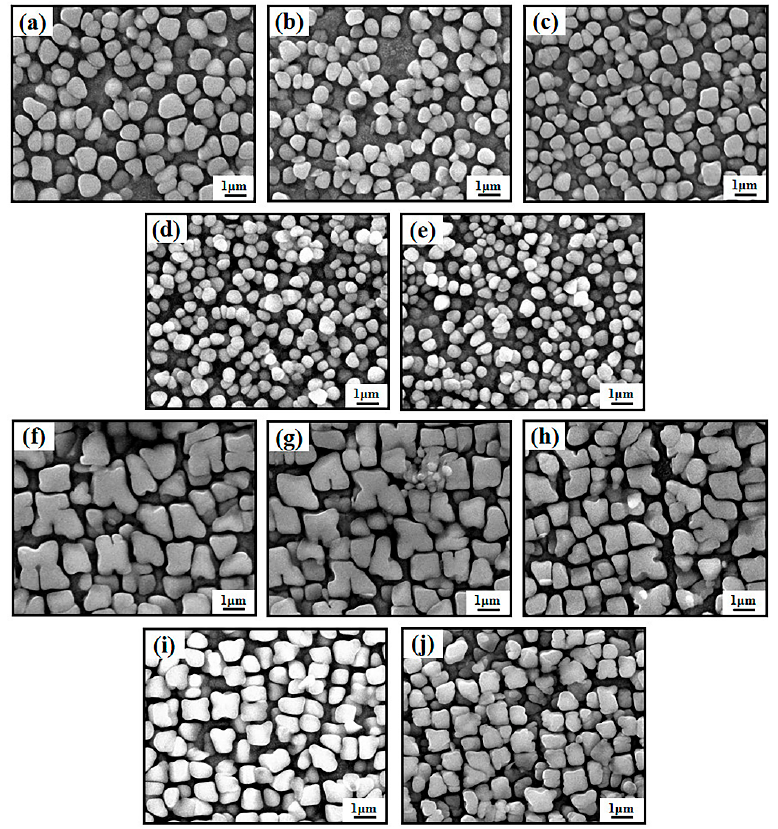
Figure 5 . Structures of the γ ’ phases in the dendrite arms ( a – e ) and interdendritic regions ( f – j )